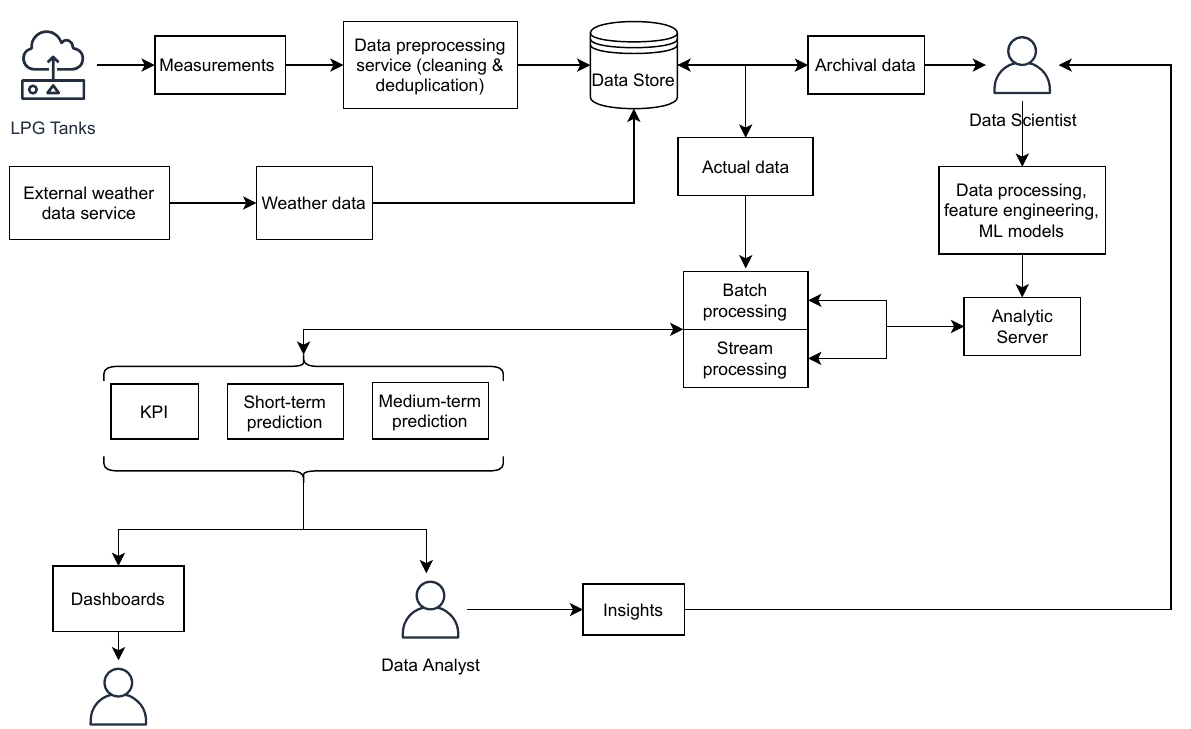
Figure 2. General workflow of the decision support system (DSS)